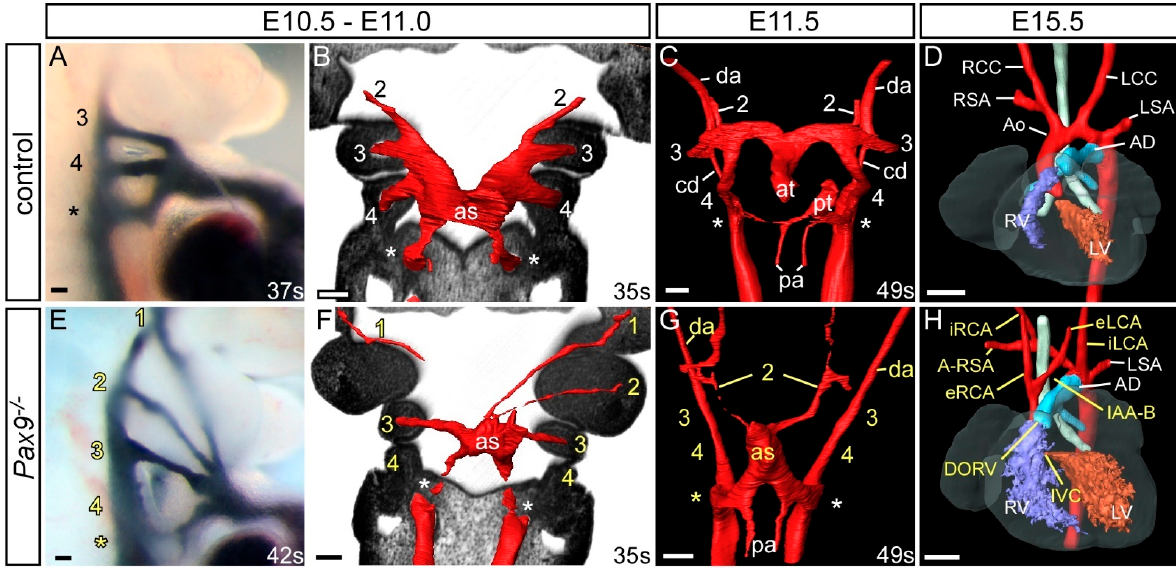
Figure 3. Cardiovascular developmental defects in Pax9 -null mouse embryos. Control ( A – D ) and Pax9 -null ( Pax9 –/– ; E – H ) mouse embryos were collected at different developmental stages and analysed for cardiovascular defects using intracardiac ink injections ( A , E ), high resolution episcopic microscopy ( B , C , F , G ) and magnetic resonance imaging ( D , H ). Control embryos at E10.5-E11.0 have the 3rd, 4th and ultimate (*) arch arteries patent to ink, are symmetrical in appearance and the 1st and 2nd have remodelled at this stage ( A , B ). In equivalently staged Pax9 -null embryos the arch arteries are abnormal, with the 1st and 2nd persisting, the 3rd thin and the 4th absent ( E , F ). At E11.5 the caudal arch arteries of control embryos start to remodel, with the outflow tract septated and the right ultimate arch artery (*) regressing ( C ), whereas in Pax9 -null embryos outflow tract septation is delayed, the 3rd arch arteries have collapsed and the 1st and/or 2nd persist ( G ). By E15.5 the pharyngeal arch arteries have remodelled into the adult aortic arch artery configuration ( D ). Pax9 -null embryos show multiple defects ( H ) including aberrant right subclavian artery (A-RSA), interrupted aortic arch (IAA), abnormal right and left internal and external carotid arteries (i/eRCA, i/eLCA) and double outlet right ventricle (DORV) with interventricular communication (IVC). Somite numbers (s) are indicated. Abbreviations: AD, arterial duct; as, aortic sac; at, aortic trunk; cd, carotid duct; da, dorsal aorta; LCC, left common carotid artery; LSA, left subclavian artery; LV, left ventricle; pa, pulmonary artery; pt, pulmonary trunk; RCC, right common carotid artery; RSA, right subclavian artery; RV, right ventricle. Scale bar: 100 µ m in ( A – C ) and ( E – G ), 500 µ m in ( D , H ). Figure adapted from